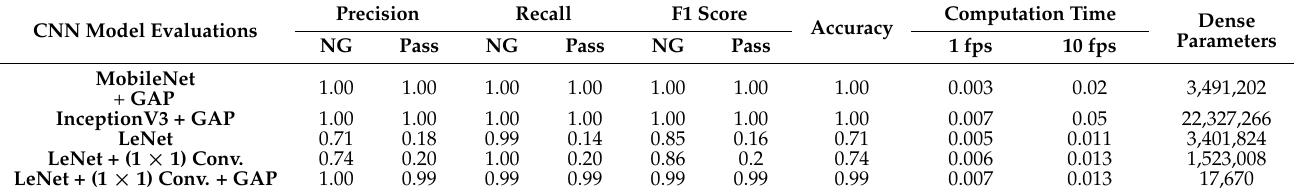
Table 7. Confusion Matrix Results for Different CNN Algorithms with K-fold Cross-Validation. CNN Model